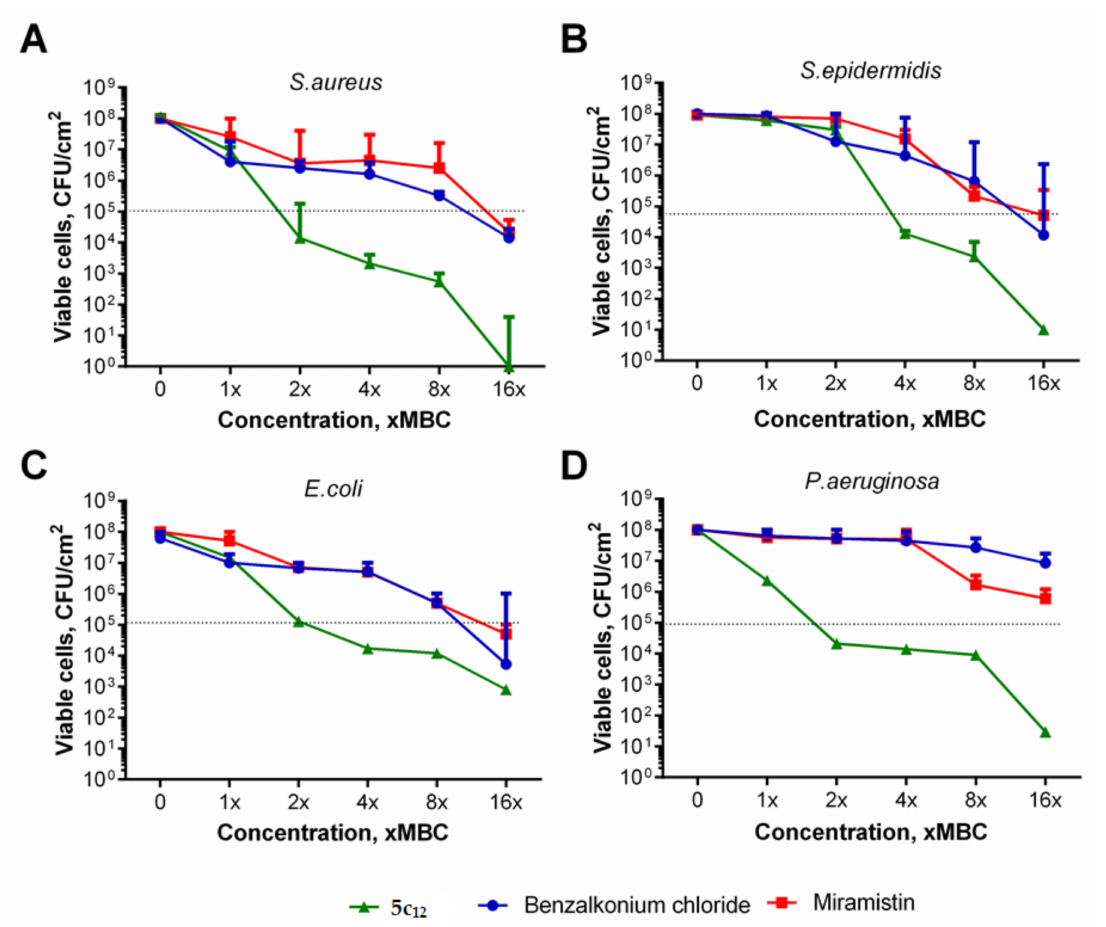
Figure 3. The e ff ect of 5c 12 and reference antiseptics on biofilm-embedded bacteria. ( A )— S. aureus ; ( B )— S. intermedius; ( C )— E. coli , ( D )— P. aeruginosa . The 48-h biofilms were treated with 1–16 × MBCs of benzalkonium chloride (circles), miramistin (squares), or 5c 12 (triangles) for 24 h and then quantified